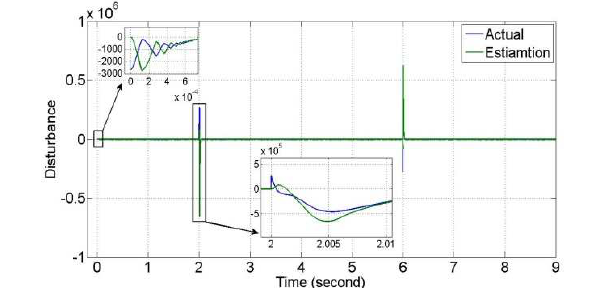
Fig. 10. Closed loop piston position